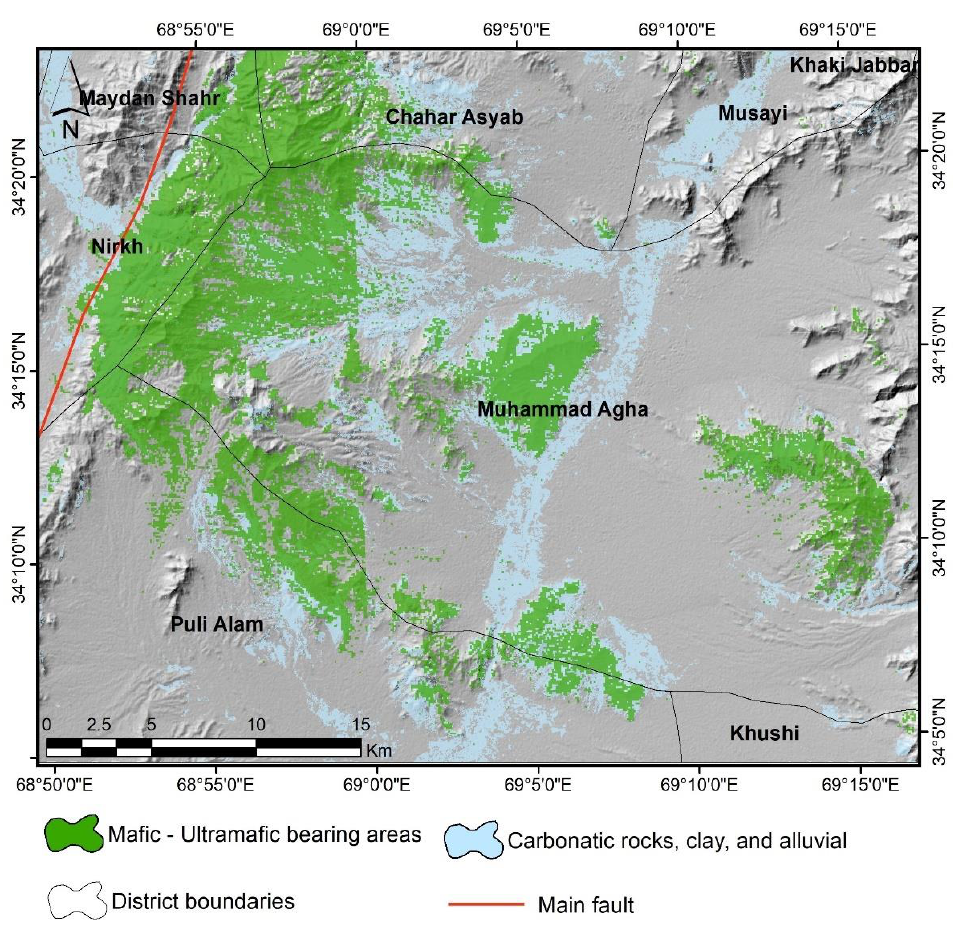
Figure 7. Thresholded pixels of ophiolites and carbonate-bearing rocks using BR 12/14 and 4/8 over the Logar Ophiolite Complex.